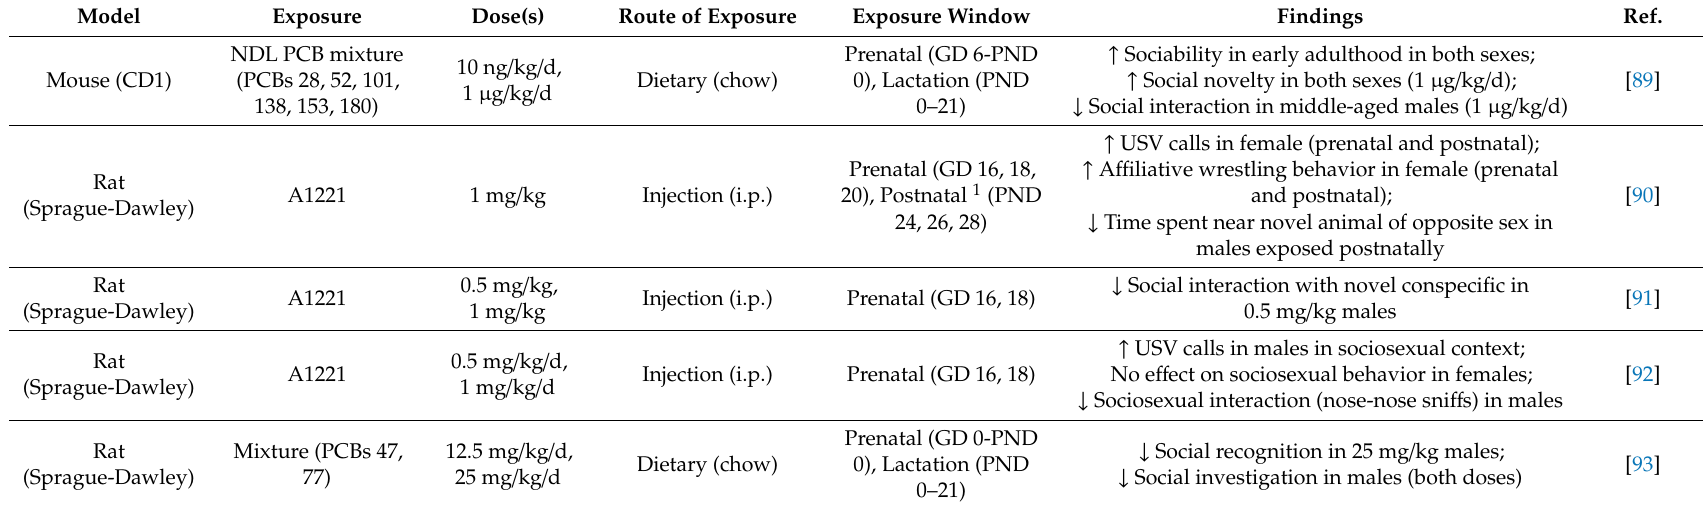
Table 2. E ff ects of developmental PCB exposure on social